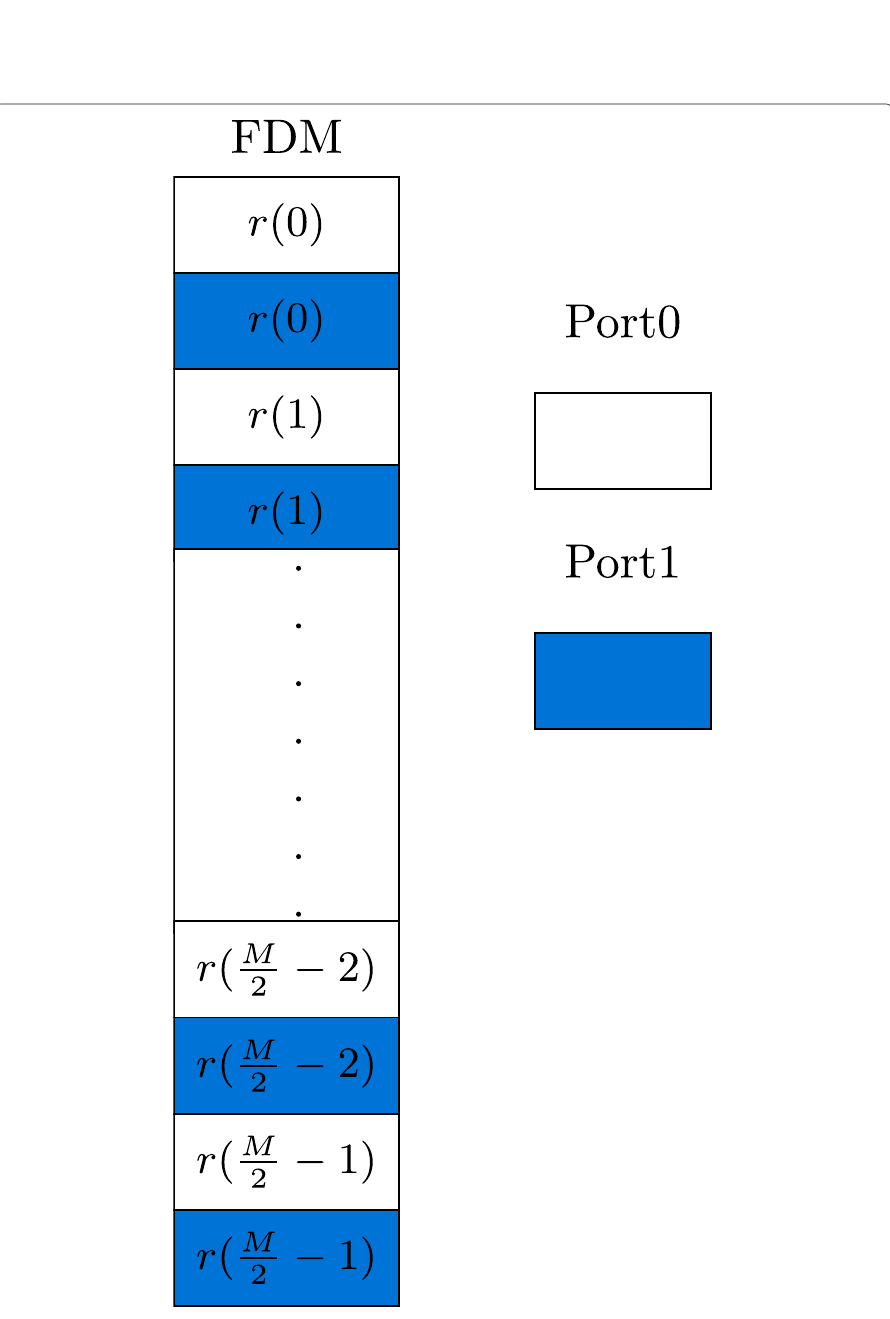
The existing ZC or QPSK based DMRS generation does not include the spectrum shap- ing; however, spectrum shaping for π/ 2-BPSK data waveform is briefly outlined in [1]. To accurately derive the channel estimates from DMRS for coherent demodulation, the spectrum shaping has to align between data and DMRS transmissions. Since the exact spectrum shaping procedure for DMRS is not known, and if we continue to follow the same spectrum shaping principles for DMRS as well as data, then it results in asymmet- ric spectrum shaping effect on port -0 and port -1, which eventually result in port-specific channel estimation and PAPR performances, which will be shown later in the Section